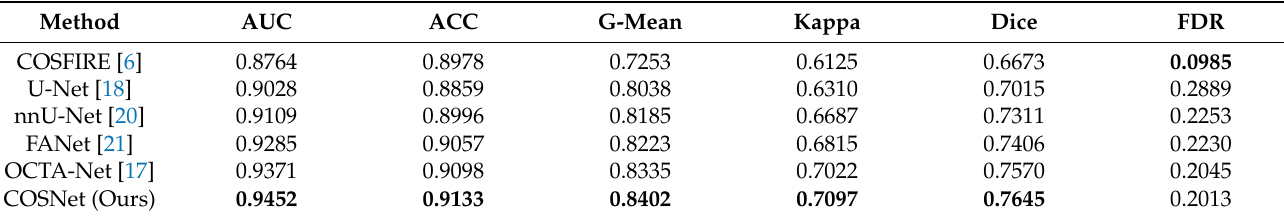
Table 3. Performance comparison on ROSE-1.